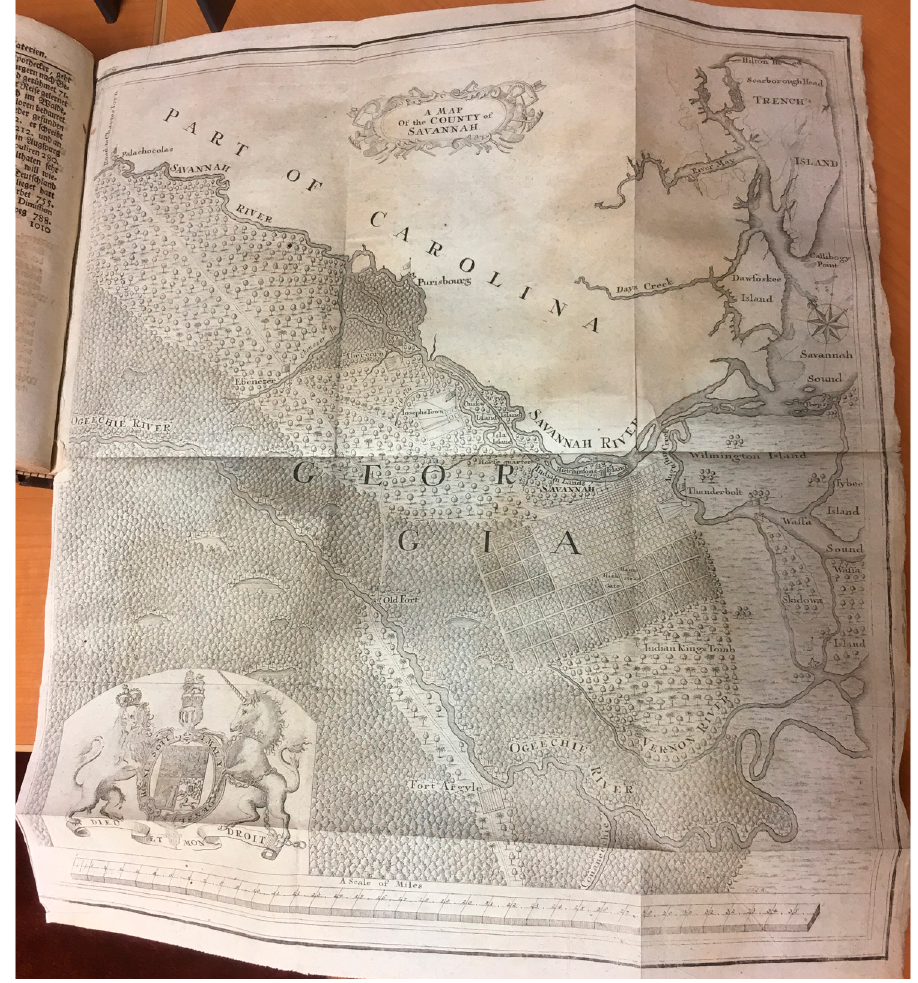
Figure 7. Engraving of Tomochichi and Toonahowi as it appears in the Detailed Reports (Urlsperger 1741). Samuel Urlsperger, ed. Der ausführlichen Nachrichten von der Königlich-Groß-Britannischen Colonie Salzburgischer Emigranten in America Erster Theil (Halle: in Verlegung des Wäysenhauses, 1741). Special Collections, A.R. Wentz Library, United Lutheran Seminary—Gettysburg. Photographed by author.